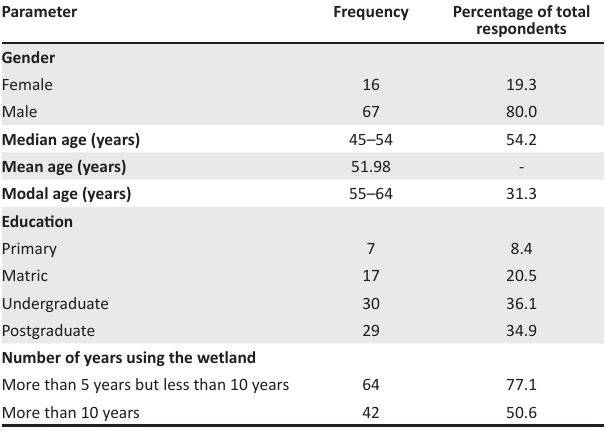
TABLE 2: Summary of the demographic background of private wetland owners.